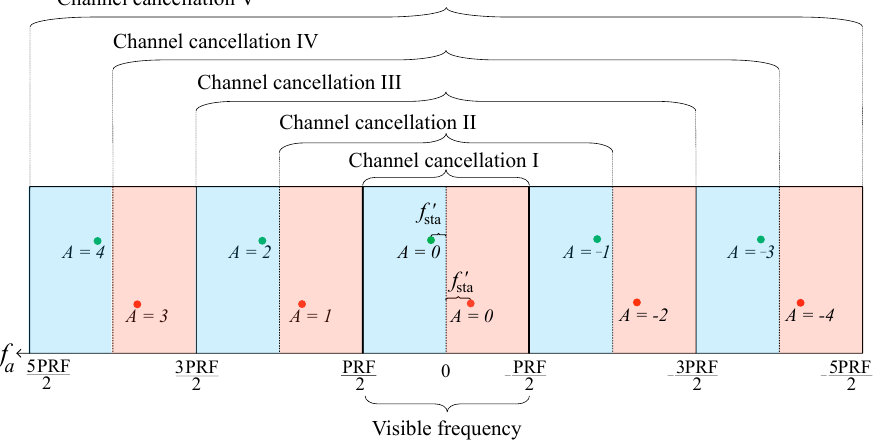
Figure 4. The aliasing effects of 10 stationary targets with all theoretical aliasing coefficients after the deramp processing in a five-channel HRWS SAR system, and each layer of the channel cancellation can suppress the stationary targets with specific aliasing coefficients